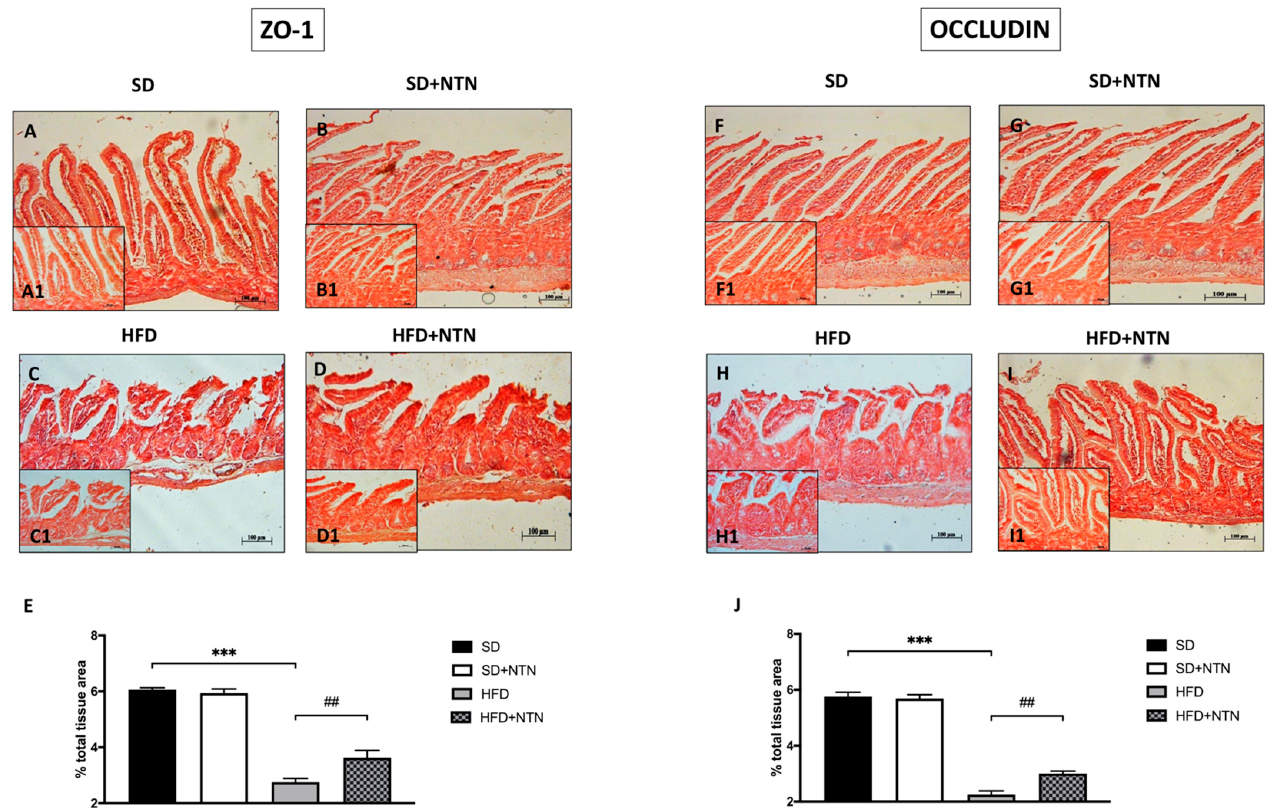
Figure 7. Effects of NTN administration on intestine epithelial integrity in HFD mice. High expressions of ZO-1 and Occludin have been found in intestinal tissues of the SD group and SD + NTN group (( A , B , E ) and ( F , G , J ) respectively) compared to the HFD group (( C , E ) and ( H , J ) respectively). The administration of NTN restored the expression of ZO-1 and Occludin proteins (( D , E ) and ( I , J ) respectively). Data are representative of at least three independent experiments. Values are means ± SEM. One-Way ANOVA test. *** p < 0.001 vs. SD; ## p < 0.01 vs. HFD.